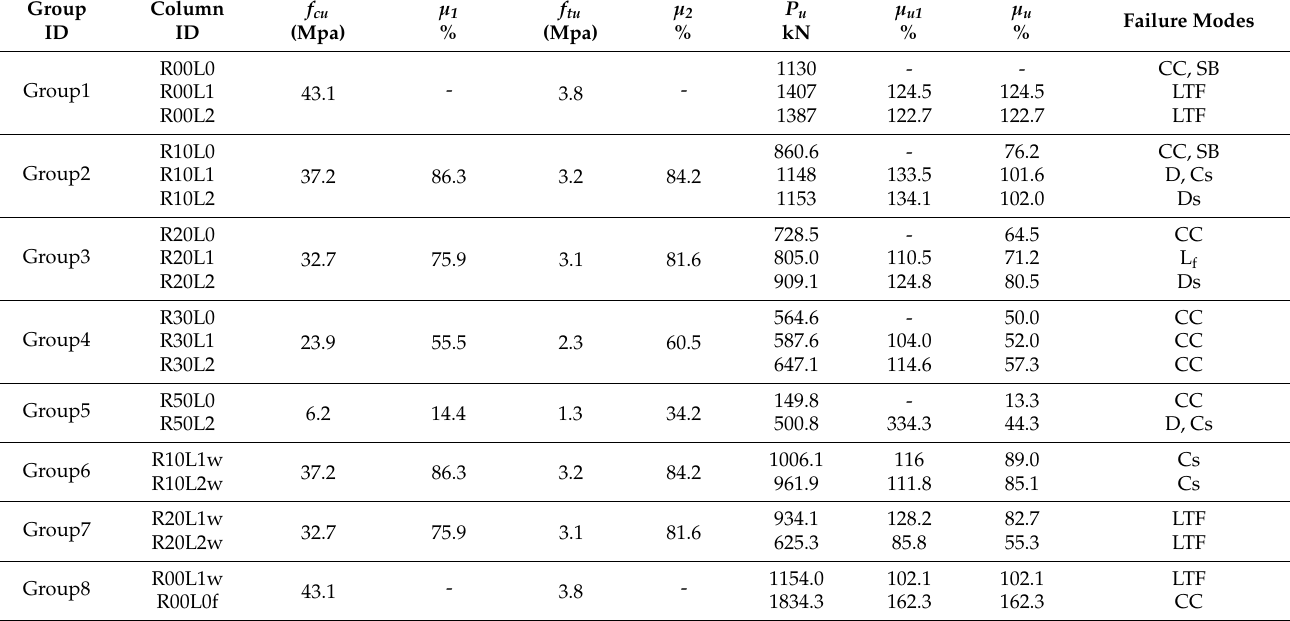
Table 6. Concrete properties and columns’ experimental